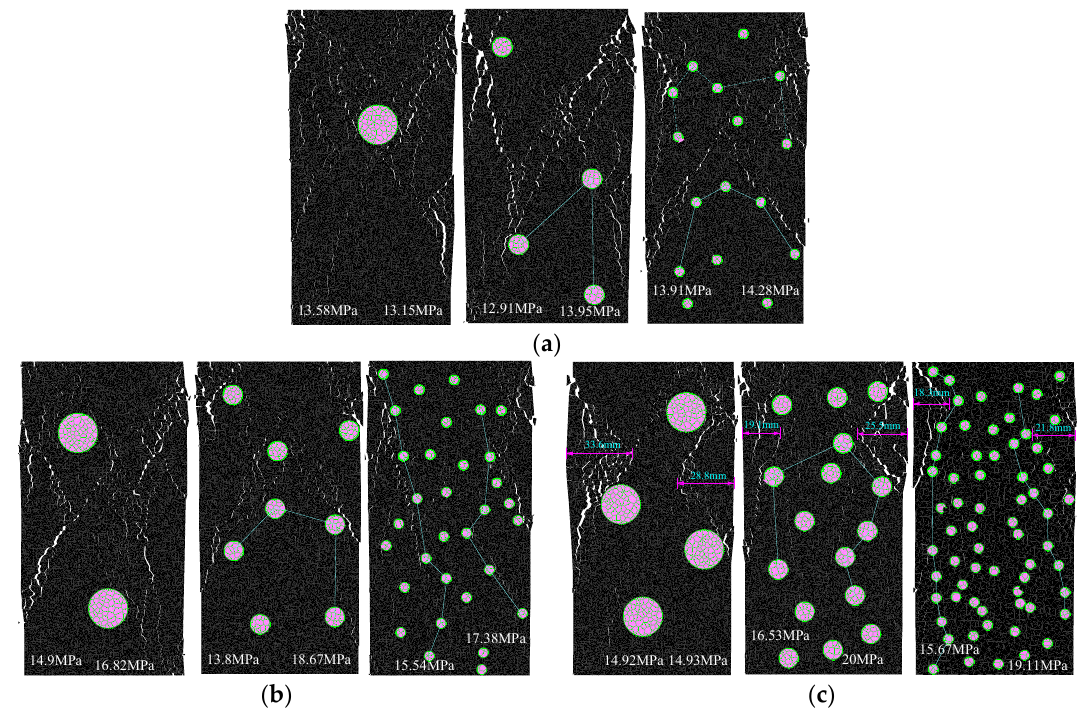
Figure 20. Crack patterns of different mineral ratios after sample is broken: ( a ) S1–S3: 2.45%; ( b ) S4–S6: 4.9%; ( c ) S7–S9: 9.8%.